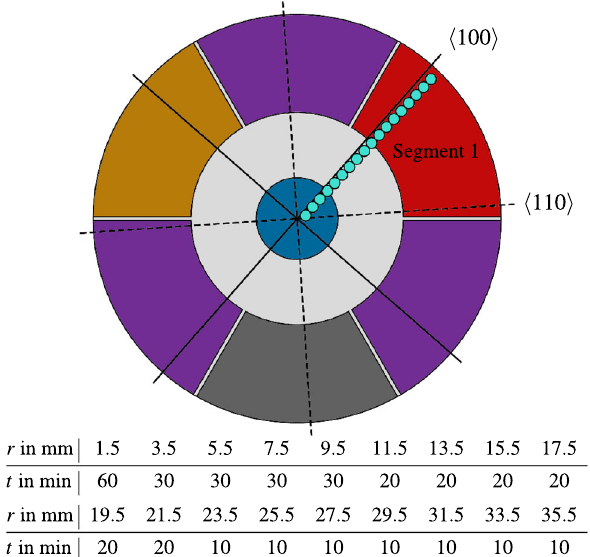
Fig. 9 Top view of the scan points and the measurement times, t , at the different radii, r , used for the commissioning of the Compton Scanner. The solid and dashed black lines indicate the (cid:4) 100 (cid:5) and (cid:4) 110 (cid:5) crystal- lographic axes,